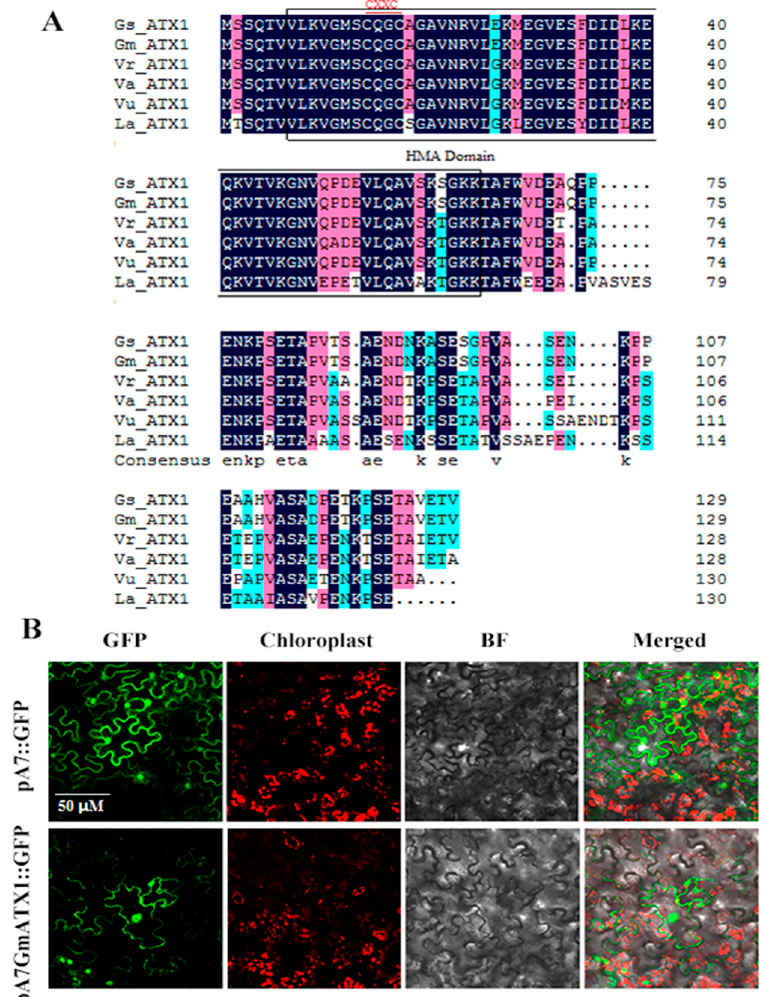
Figure 1. Sequence analysis and subcellular localization of GmATX1. ( A ) Multiple alignment of the amino acid sequences of GmATX1 and other plant homologues. CXXC motif, heavy metal binding core motif. Gs, Glycine soja ; Gm, Glycine max ; Vr, Vigna radiata ; Va, Vigna angularis ; Vu, Vigna unguiculata ; La, Lupinus angustifolius . ( B ) Subcellular localization of the GmATX1 protein in tobacco leaf cells. pA7GmATX1::GFP, a fusion protein; pA7GmATX1::GFP, a null-loaded protein; BF, Brightfield. Fluorescence images of protoplasts expressing GFP fusion proteins were obtained using the LSM780 confocal microscopy imaging system.